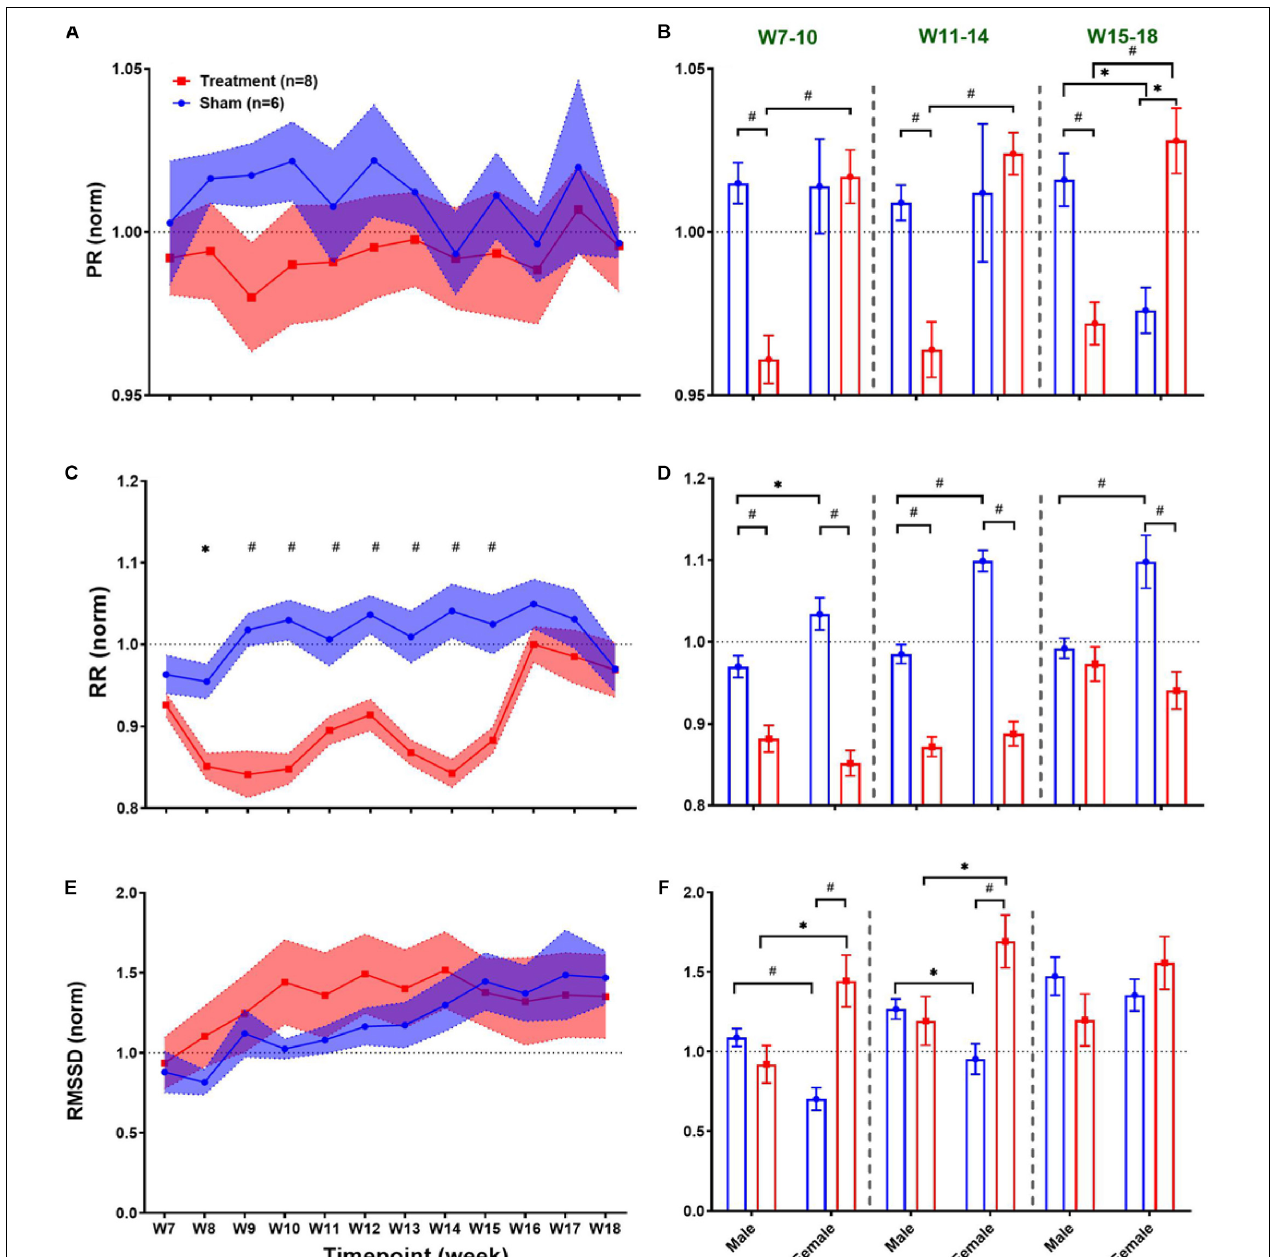
FIGURE 4 | Normalized long-term trends for ECG morphology and HRV time-domain features (mean ± SEM). (A,B) PR slightly reduces in the Treatment group and increases in the Sham group (not significant; p > 0.05) and slowly recovers toward the VNS endpoint (W14). The average effects for VNS_Early (W7–10), VNS_Late (W11–14), and Recovery (W15–18) periods are compared between groups (Treatment vs Sham and male vs female). Male–female differences are shown for three periods. (C,D) The long-term effect of VNS on RR is significantly different between the Treatment and Sham groups even during the first week of recovery (W15). While sex difference was significant only in the Sham group over three phases, Treatment effect remains significant until W15 for both male and female rats and only for female rats after W15. (E,F) There is no significant difference between the Treatment and Sham groups in the long-term effect of VNS on RMSSD. However, when male and female rats were compared from each group, a significant increase in RMSSD was observed in female rats by VNS, during VNS_Early and VNS_Late phases. * p < 0.05 and # p < 0.01.